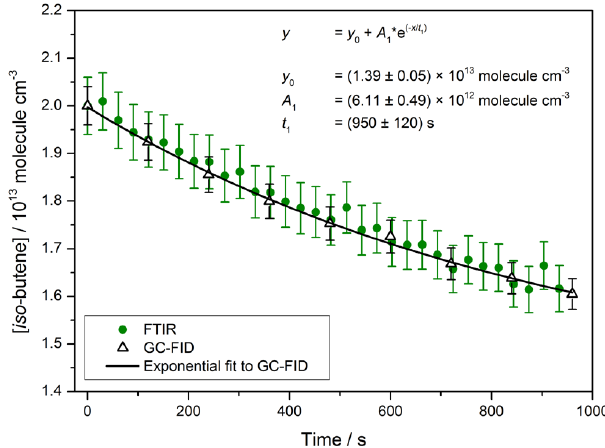
Figure 5. Decay of iso -butene as a function of time through reaction with OH in HIRAC (750mbar, 294 K), measured using GC-FID on a 2min time resolution. The data are fitted with a first-order expo- nential decay (purely empirical) to allow calculation of [HC] on the same timescale as the 60s averaged FAGE data. Time = 0 s indi- cates photolysis lamp turn-on time and uncertainties are quoted to ± 1 σ . Error bars are representative of the precision in the GC-FID ( ∼ 2%) and FTIR ( ∼ 3%) measurements to 1 σ